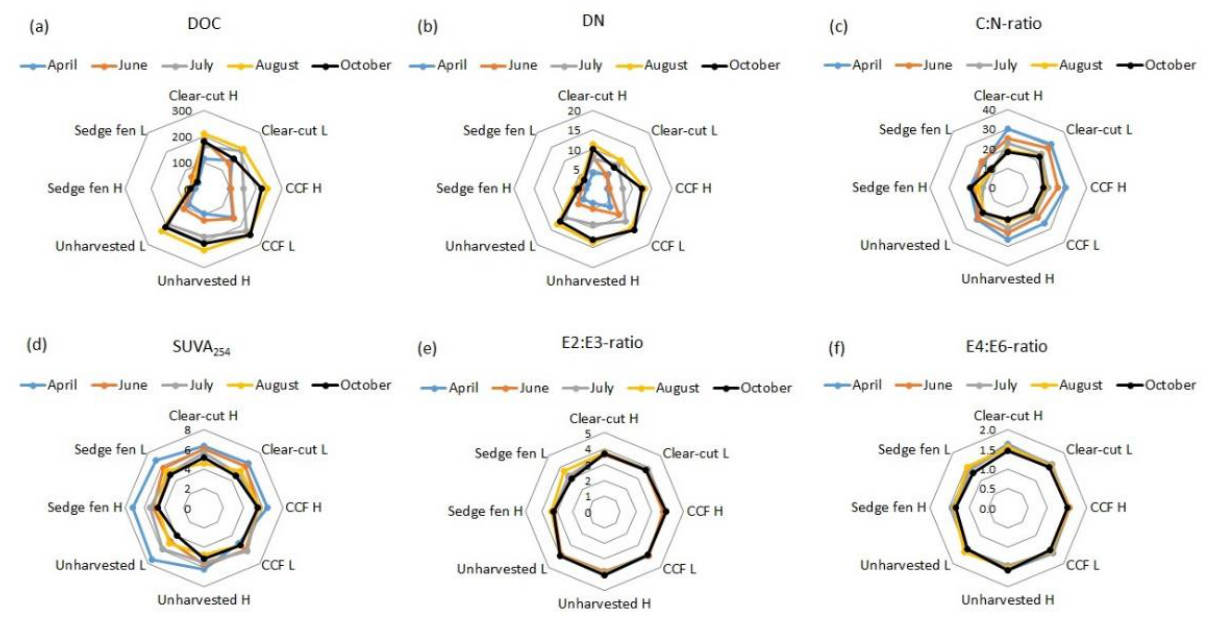
Figure 2. Water ( a ) dissolved organic carbon (DOC; mg L − 1 ) and ( b ) dissolved nitrogen (DN; mg L − 1 ) concentrations, ( c ) carbon to nitrogen (C:N) -ratios, ( d ) SUVA 254 (L mg − 1 m − 1 ), and ( e ) E2:E3 and ( f ) E4:E6-ratios in the peat columns collected from the clear-cut, continuous cover forestry (CCF; 12 m 2 ), unharvested forest in Paroninkorpi, and alluvial sedge fen in Sudenpesänkangas. H = high water table, L = low water table.